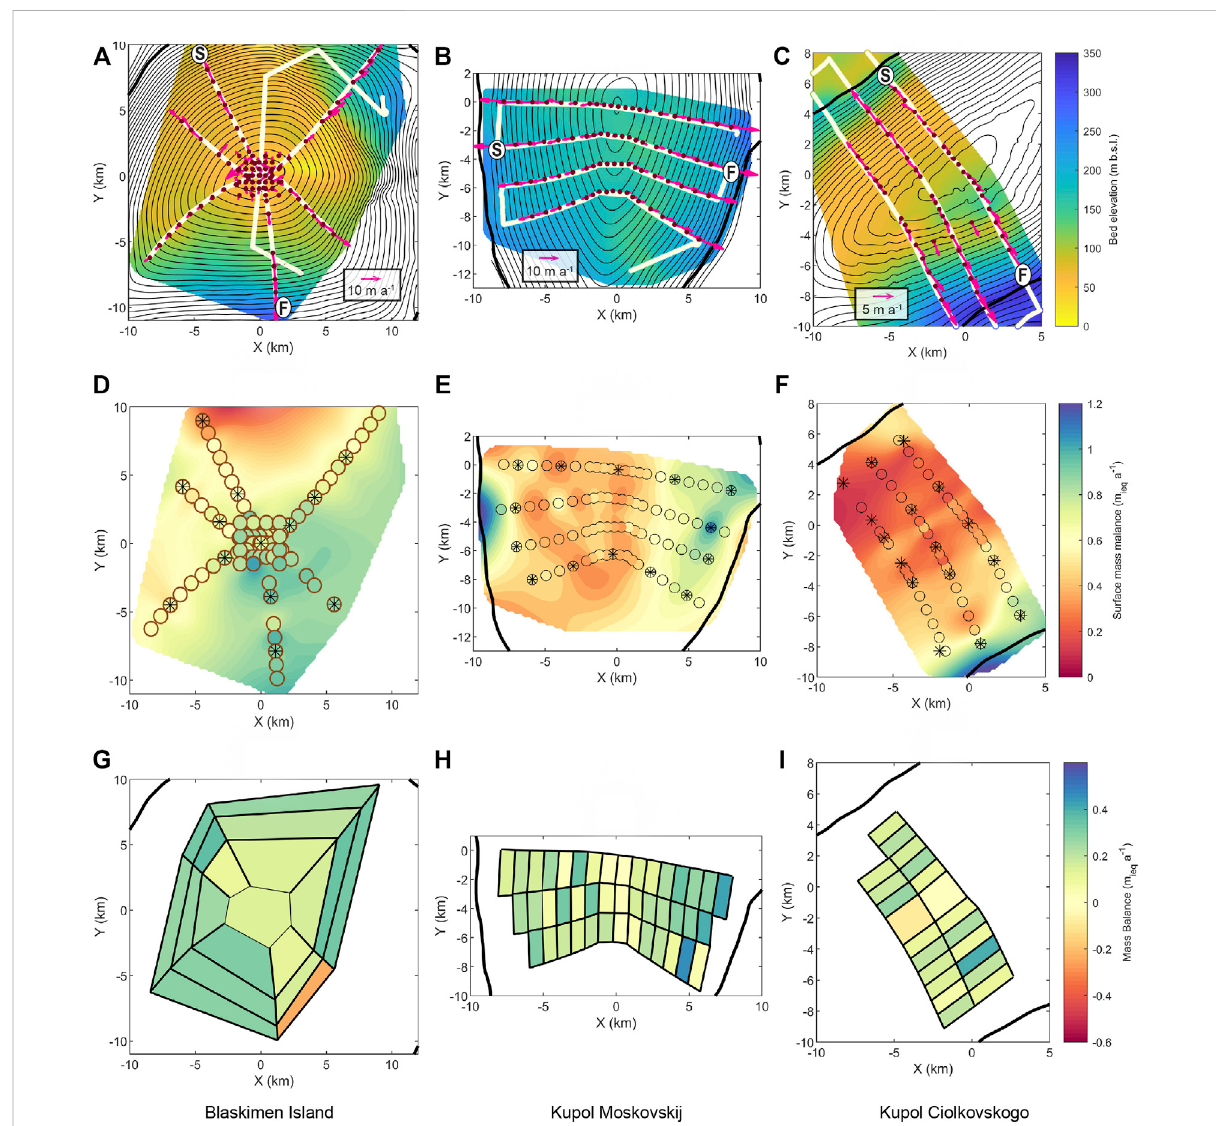
FIGURE 2 Glaciological settings and mass balance over ice rises in the Fimbul region. Panels in each column show the data and results from Blåskimen Island (BI, left), Kupol Moskovskij (KM, center), and Kupol Ciolkovskogo (KC, right). Data from Blåskimen Island (A, D, and G) have been published in Goel et al., 2017. Panels in the fi rst row (A – C) show the surface elevation contours (10 m) derived by GNSS surveys (Figures 1B – D) together with bed topography derived from radar surveys along the white curves. Radargrams connecting the starting (S) and fi nishing (F) places are shown in Figure 3. Blue dots show the location of installed stakes, while pink arrows show the ice- fl ow vectors measured with these stakes. Panels in the second row (D – F) show SMB derived at stake positions and interpolated map using these data. Circles show the stake position and estimated SMB. Circles with ‘ * ’ inside show the stakes where we have surface density measurements as well. Note that the same colorbar is used for all three panels, despitethelargevariationsofice-risemeanSMB.Panelsinthethirdrow (G – I) showthemassbalanceestimatedusingpolygonsetupwitha γ valueof 0.8 (Eqs 1, 2). For these estimates, we used stake-derived SMB between 2013 and 2014 for BI, 2012 – 2013 for KM, and 2012 – 2013 for